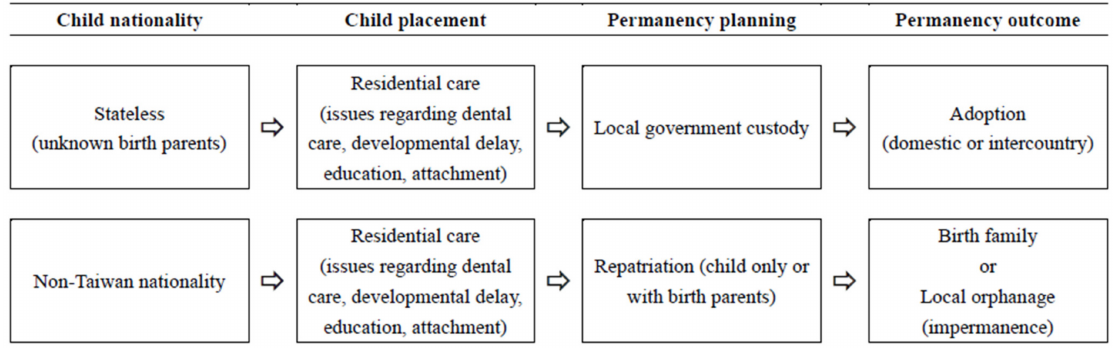
Figure 2. Permanency/placement planning for children of migrant workers in